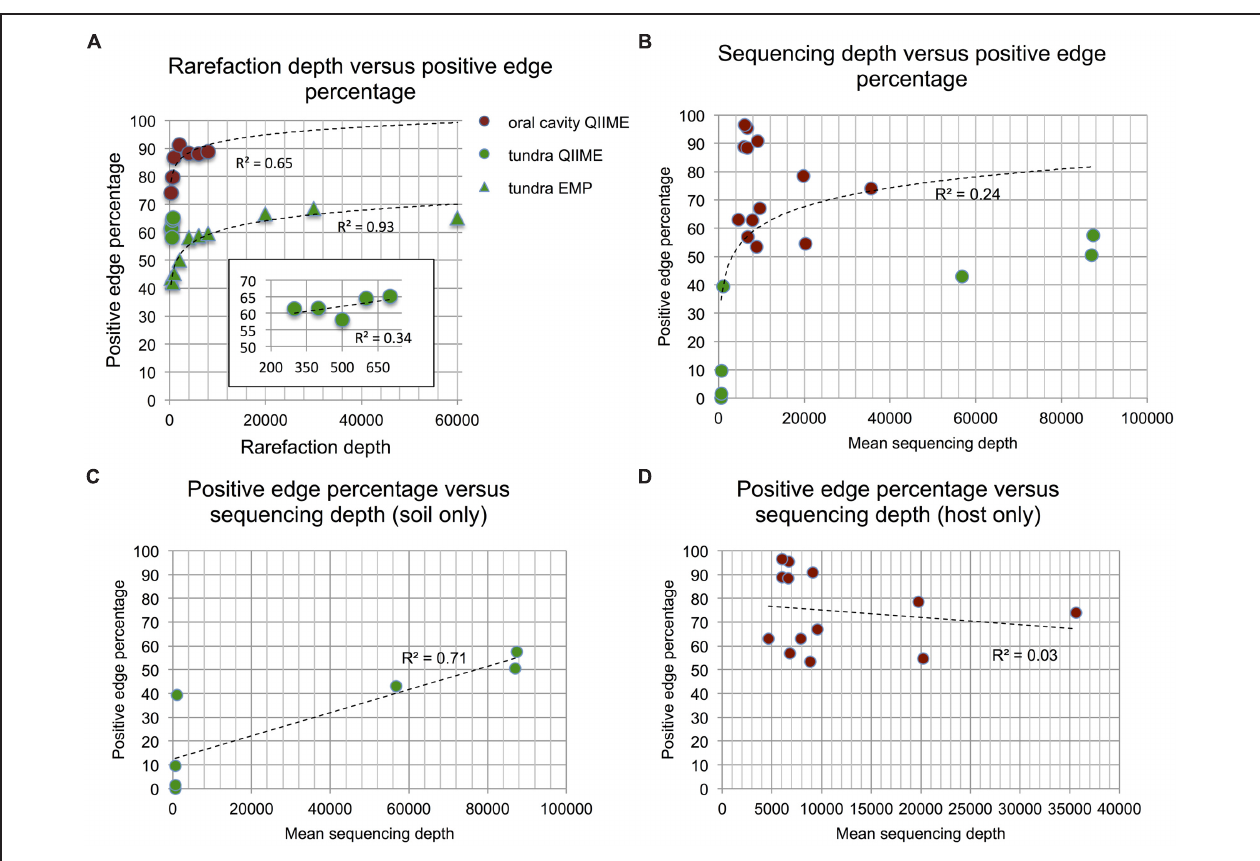
FIGURE 3 | Impact of sequencing depth. Oral cavity and tundra networks were re-constructed from QIIME and EMP data rarefied to different depths (minimum occurrence was set to 13 for tundra QIIME, to 22 for tundra EMP and to 137 for oral cavity). In all cases, positive edge percentage (PEP) is correlated with sequencing depth ( A ; Spearman’s rho tundra QIIME: 0.7, p -value: 0.23, tundra EMP: 0.95, p -value: 2E-16, oral cavity: 0.75, p -value: 0.07). The trend line for oral cavity and tundra EMP is a logarithmic function of sequencing depth, whereas a linear trend line was fitted to tundra QIIME. Although sequencing depth is